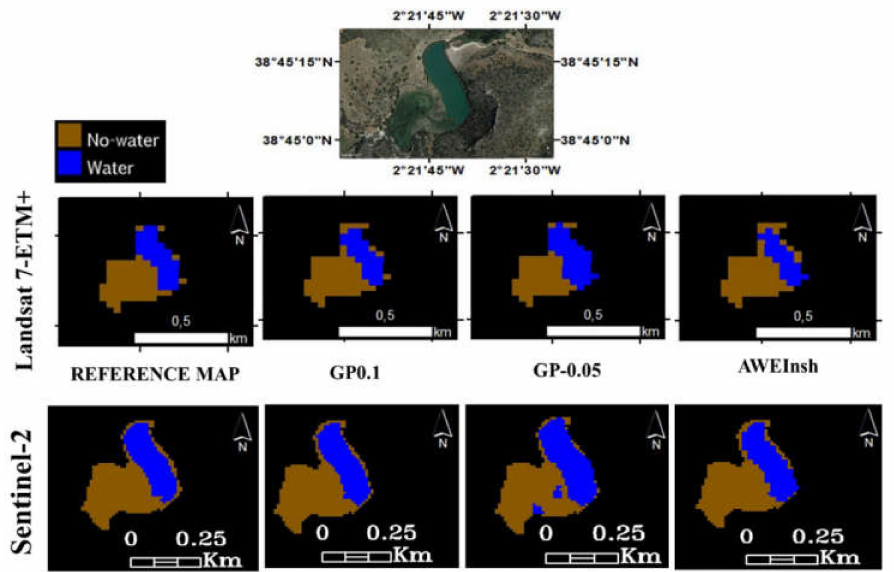
Figure 7. Results of the classification from the GP0.1, GP-0.05, and AWEInsh for Laguna del Arquillo from both Landsat-7 ETM+ and Sentinel-2 images, corresponding to dates 29 and 28 July 2017, respectively. The reference map for date 29 July 2017 is also